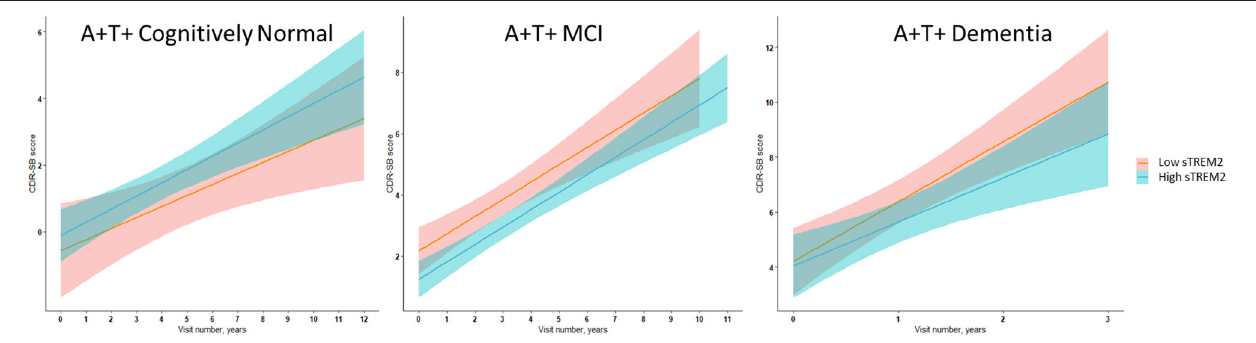
FIGURE 2 | Illustrative linear regression with 95% CI plots for sTREM2 levels at the 25th and 75th percentiles at baseline vs. CDR-SB score longitudinally for A + T + participants with MCI stage of AD ( n = 111) or AD dementia ( n = 57) and in A + T + cognitively normal participants ( n = 16) also used for sensitivity analyses described in Supplementary Tables 11 – 15